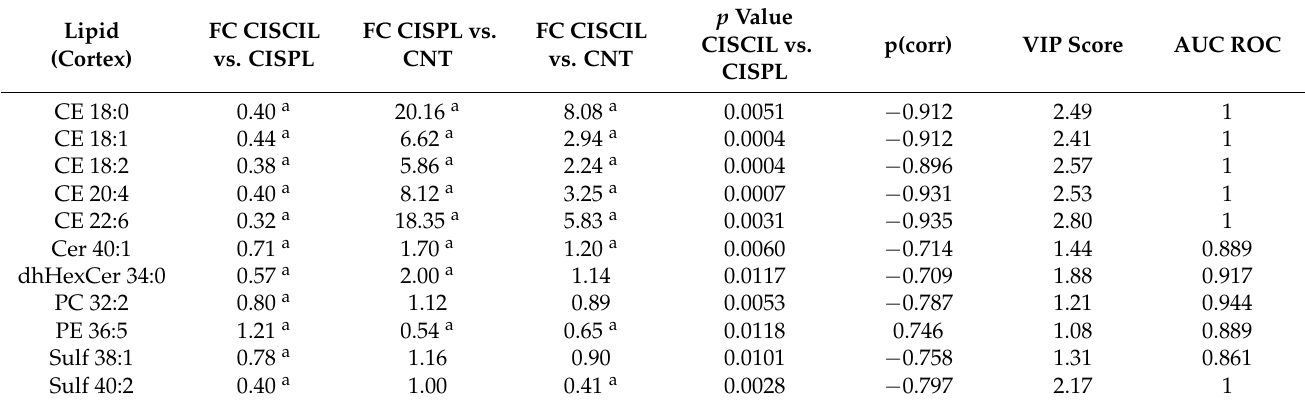
Table 4. Selected cortex lipids that are potential biomarkers of cilastatin nephroprotection. The CISCIL group was compared with the CISPL group. p -values from univariate analysis are considered. FC and AUC from the ROC are included. Lipids with p -value < 0.05, FDR < 0.1, |p(corr)| > 0.5, and VIP score > 1 from the OPLS-DA model are included.